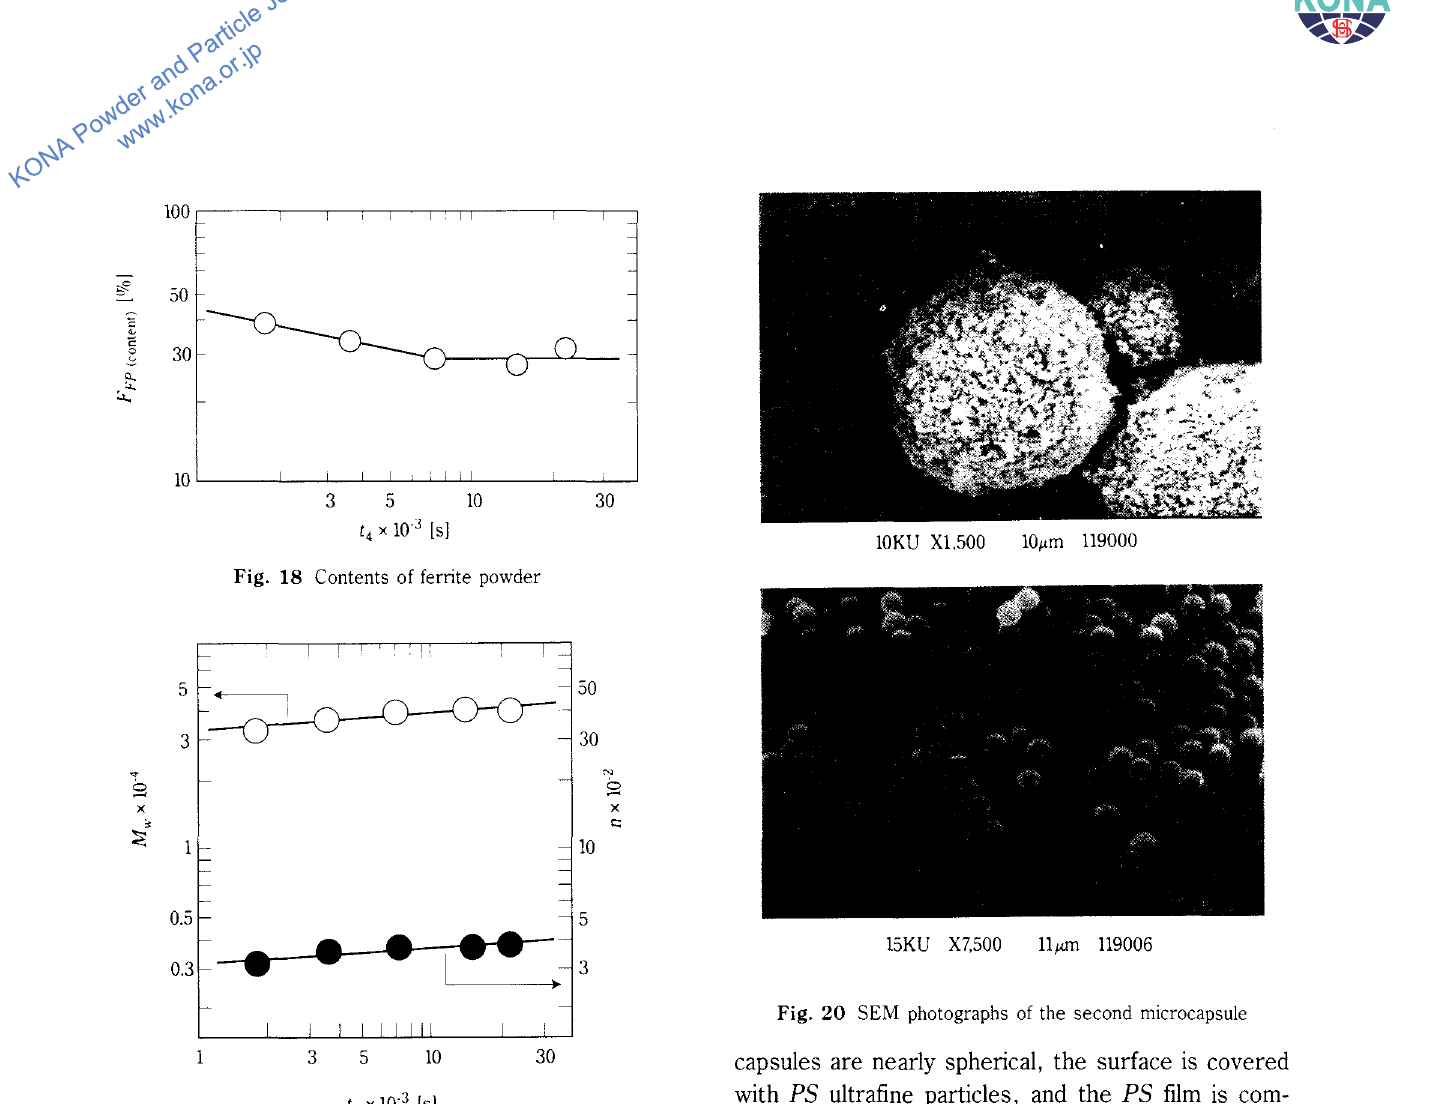
Fig. 20 SEM photographs of the second microcapsule capsules are nearly spherical, the surface is covered with PS ultrafine particles, and the PS film is com posed of multiple layers. It was investigated whether PS ultrafine particles would dissociate or not when the suspension system of the second microcapsule was irradiated with ultrasonic waves. No such dis sociation was observed. Hence, it is learned that the adhesive layer of the PS ultrafine particles is formed by